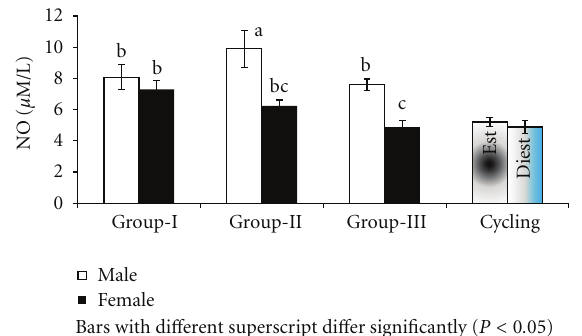
Figure 1: NO culture supernatant in Murrah bu ff aloes of di ff erent sex, age, and stage of cycle.